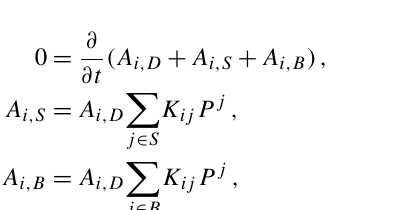
Figure 3. The conceptual reversible scavenging model for the ra- dionuclides. The radioisotopes, 230 Th and 231 Pa, are depicted in orange when in the dissolved phase. Just like with the other PISCES tracers, the dissolved and particulate radionuclides are transported by circulation and eddy